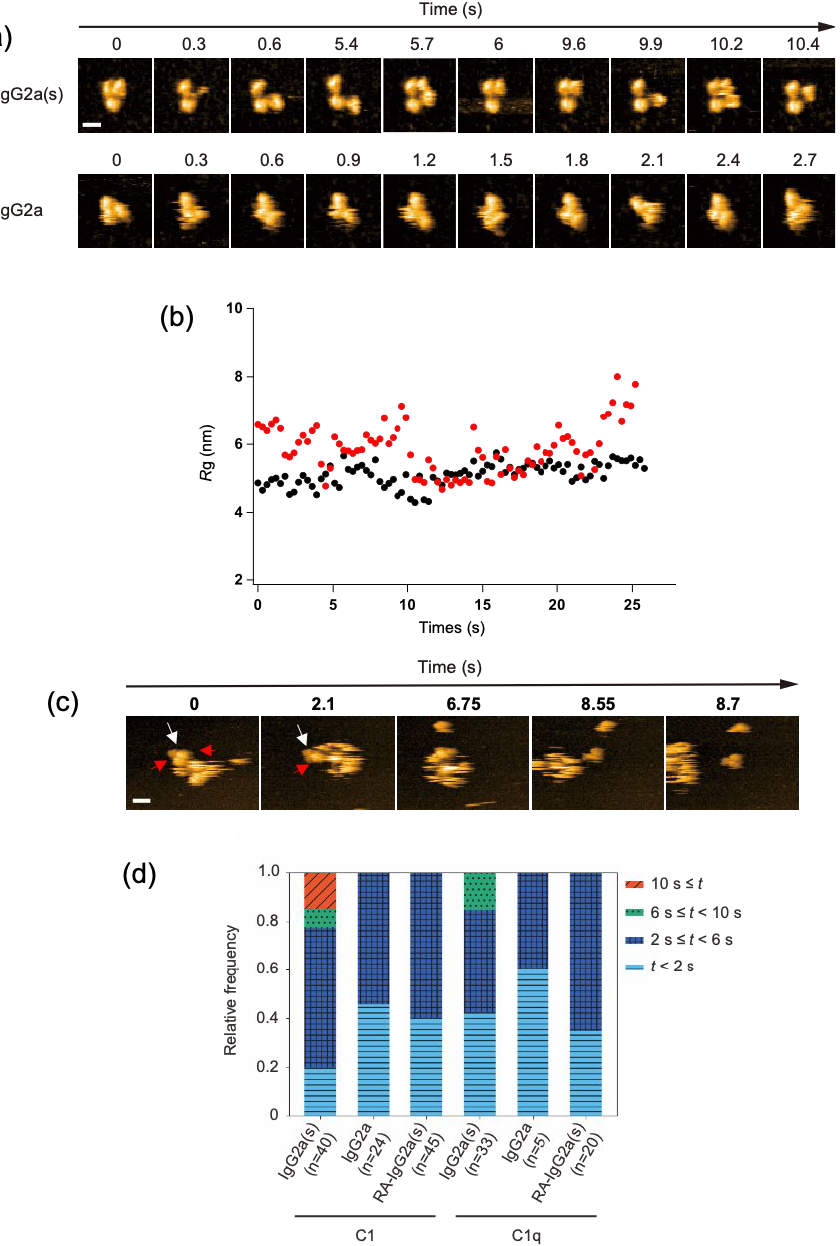
Figure 3. HS-AFM observation of IgG2a(s) and IgG2a, and their interactions with C1/C1q. ( a ) Clipped HS-AFM images of IgG2a and IgG2a(s) observed on the mica surface. Scale bar = 10 nm. ( b ) The R g value was calculated for IgG2a (black) and IgG2a(s) (red) as the average distance between the center of mass and the globular domains, as described previously [26]. ( c ) The interaction of IgG2a(s) and C1q was observed at the single-molecule level. The white arrow indicates IgG2a(s), whereas the red arrow indicates the C1q head binding to IgG2a(s). Scale bar = 20 nm. ( d ) The dwell times of C1/C1q on IgG2a, IgG2a(s), and reduced and alkylated IgG2a(s) (RA-IgG2a(s)). The relative frequency of C1/C1q observed during a given window of the dwell time ( t ) on different antibodies.